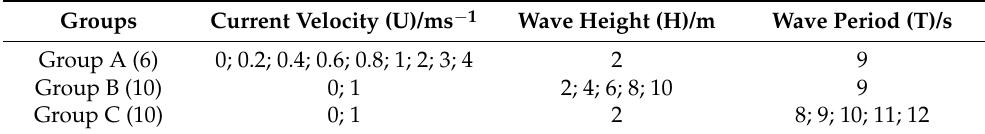
Table 3. Current velocity and regular wave